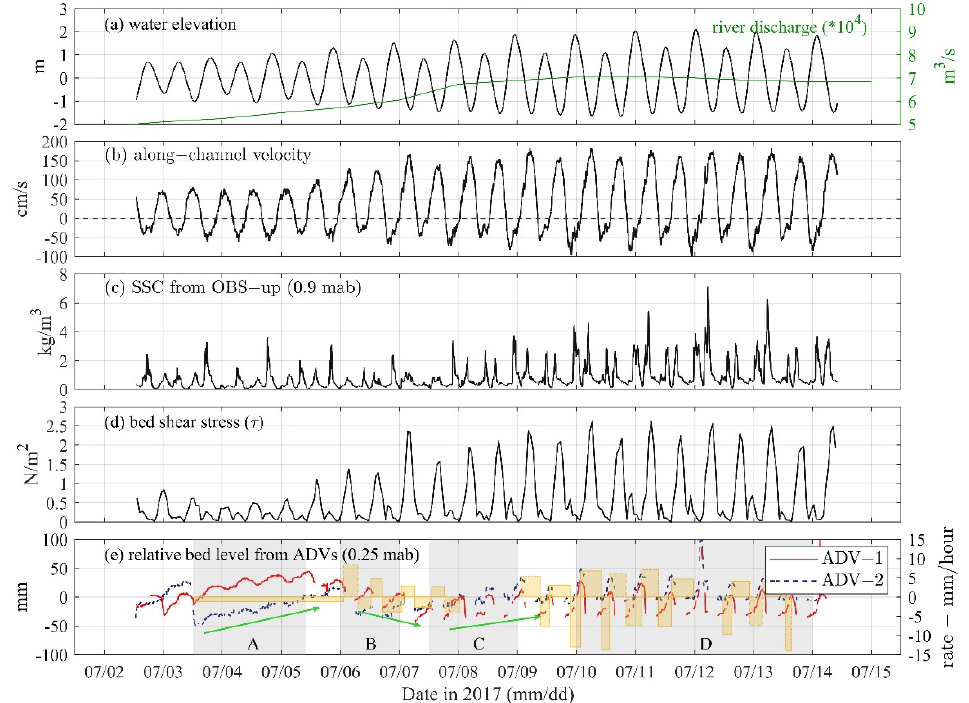
Figure 4. Observed variables: ( a ) discharge (Datong Gauge Station, 600 km upstream) and water elevation (OBS), ( b ) along ‐ channel current velocity (ALEC), ( c ) suspended sediment concentration (SSC), ( d ) bed shear stress, and ( e ) relative bed level and the rate of bed level changes (ADV). The positive values of along ‐ channel current velocity denote ebb currents.